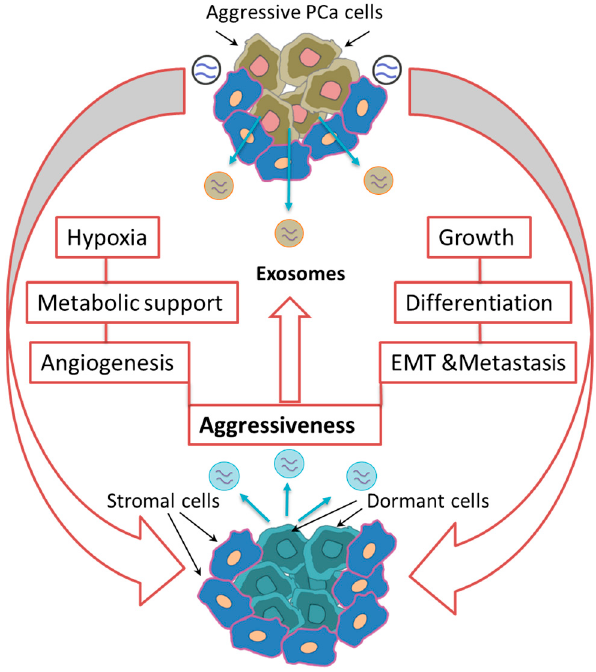
Figure 1. Birds in a nest: Role of exosomes in intra-prostate cancer (PCa) communications. PCa cells communicate with each other by transfer of exosomal cargo proteins and nucleic acids within the tumor microenvironment. In heterogenic tumor cells and in premetastatic niche, shedding of exosomes from vicious PCa cells reactivate dormant PCa cells to gain new aggressive traits through inducing of cell growth, differentiation, epithelial-mesenchymal transition (EMT), metabolic adaptation under hypoxic conditions, and angiogenesis.